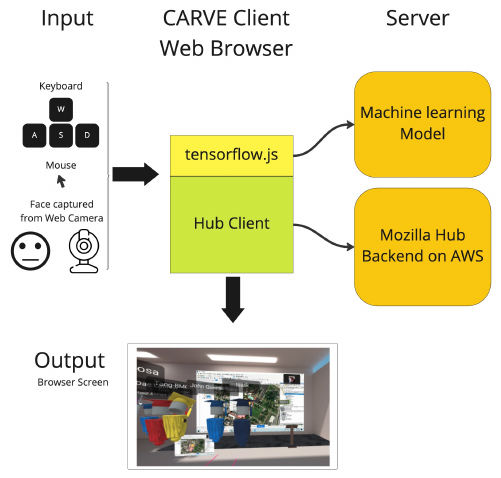
Figure 7. System